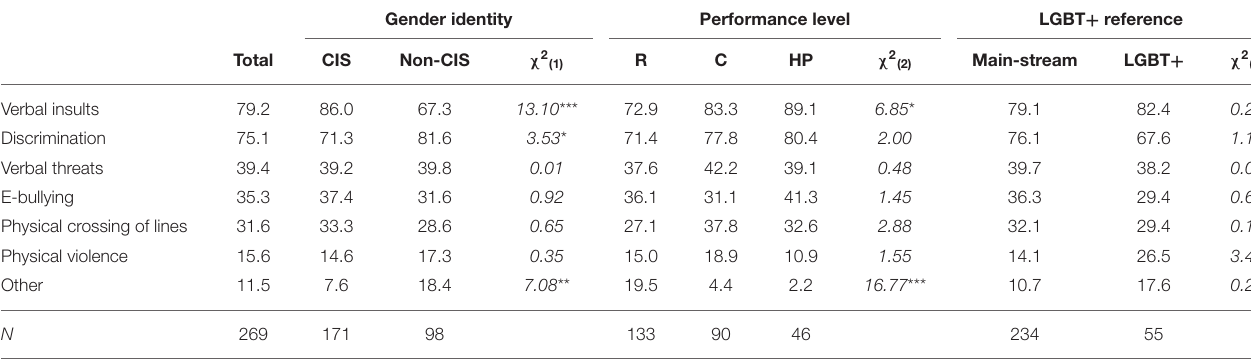
TABLE 3 | Forms of personal negative experiences by gender identity, performance level, and LGBT + reference (%). Gender identity Performance level LGBT + reference